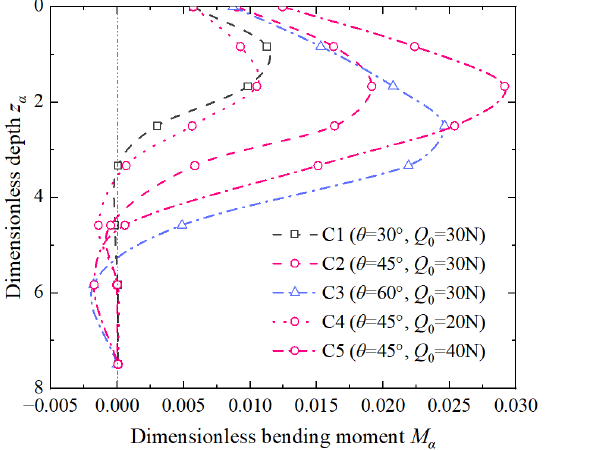
Figure 13. Dimensionless bending moment and subgrade reaction profiles under different cycle numbers. ( a ) bending moment profiles; ( b ) subgrade reaction profiles.